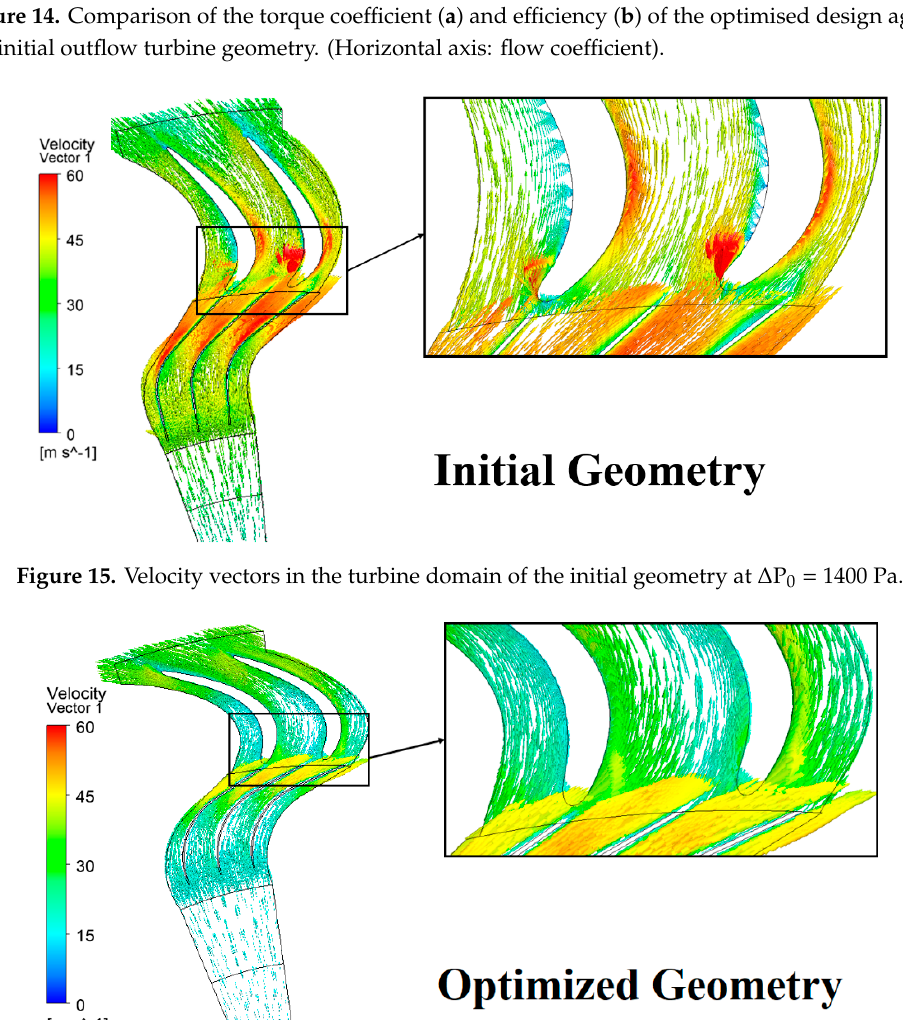
Figure 16. Velocity vectors in the turbine domain of the optimised geometry at (cid:1986)(cid:1842) (cid:2868) = 1400 Pa.